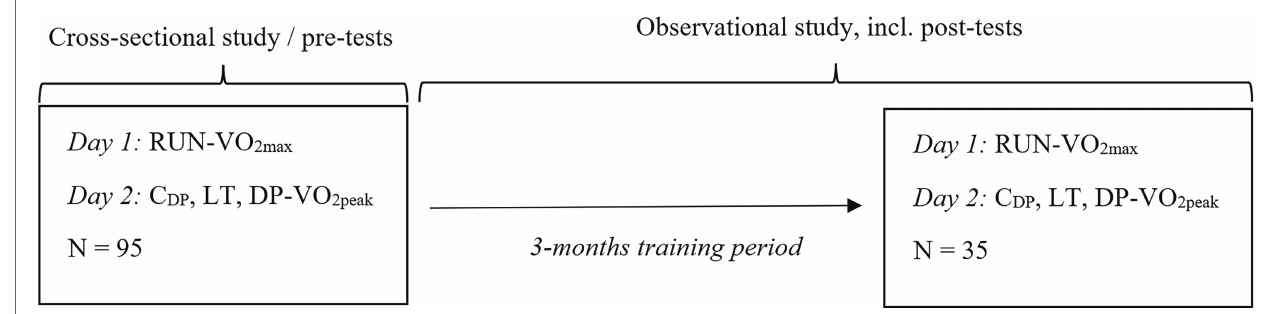
FIGURE 1 | An overview of the study protocol.